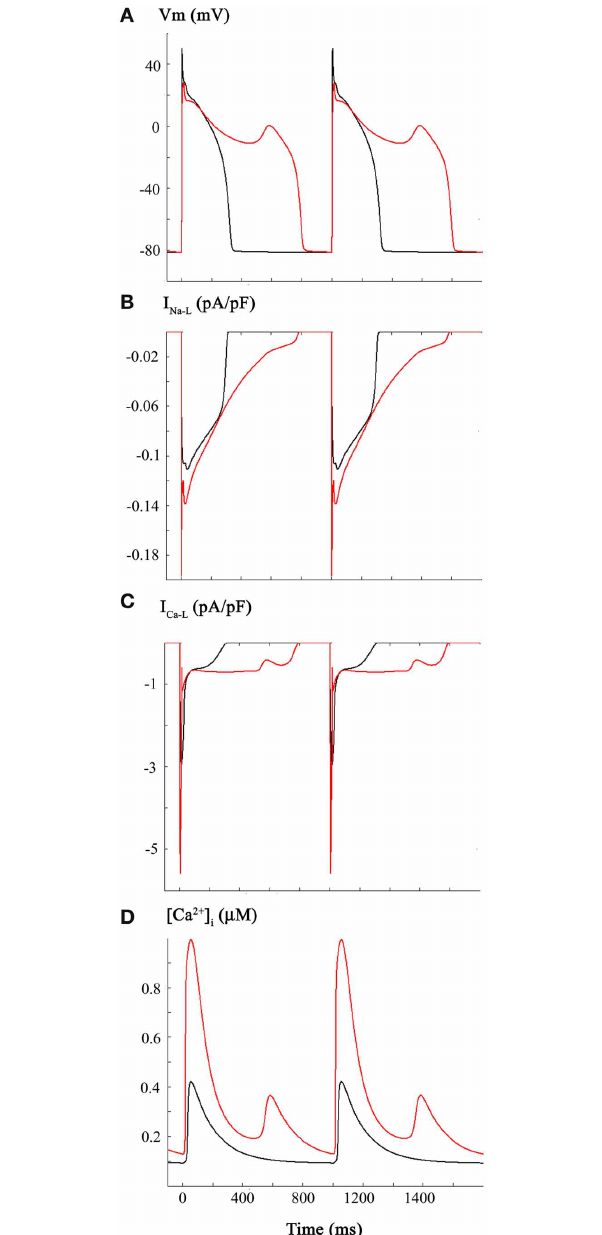
FIGURE 3 | Changes in the human ventricular action potential as a consequence of CO-induced changes in both I Na and I Ca - L . The layout and color-coding of this Figure is identical to that described for Figures 1 , 2 . As shown in Panel (A) when the CO-induced changes in Na + and Ca 2 + currents are combined there is marked lengthening of the action potential and a significantly increased incidence and frequency of EADs occurring during the somewhat depolarized plateau phase of the action potential. I Na - L records are shown in Panel (B) . Panels (C,D) show the changes in I Ca - L and [Ca 2 + ] i . Note that the changes in I Ca - L differ from those in Figure 2 as a result of the alterations in action potential waveform caused by the combined changes in I Na and I Ca - L .